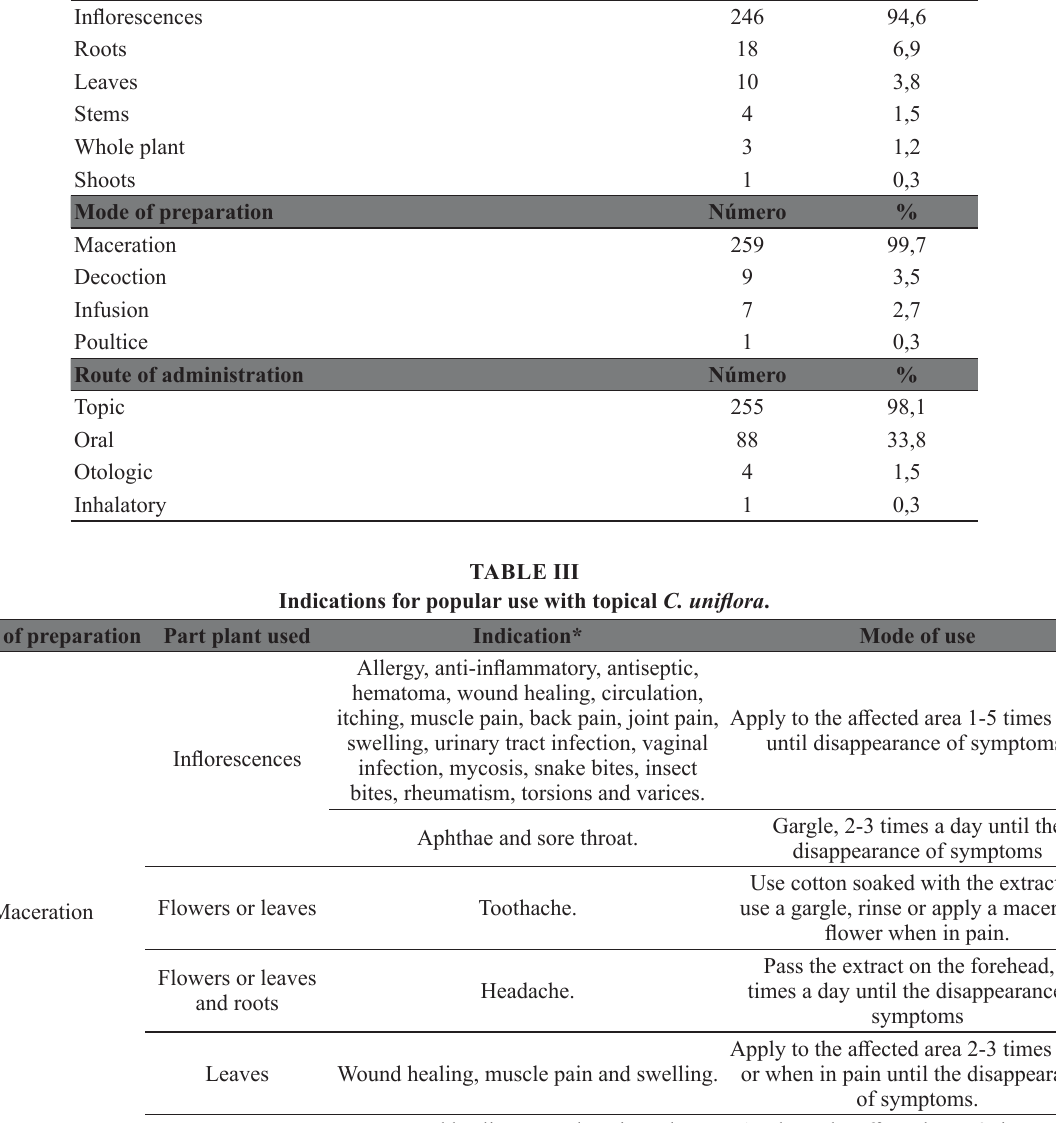
Plant parts used, modes of preparation and routes of administration cited by C. uniflora users. Plant part used